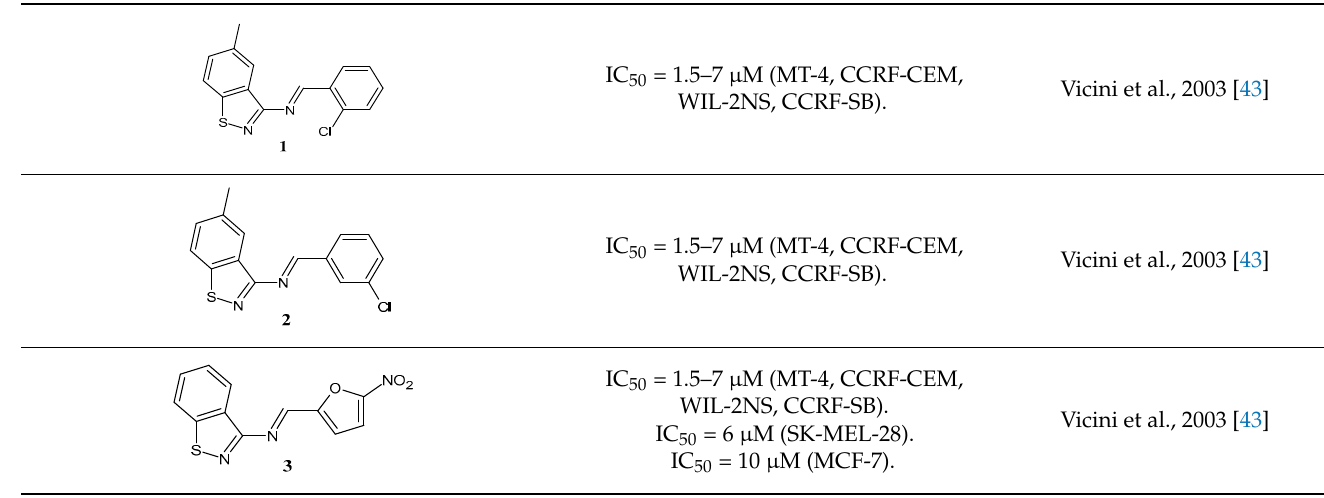
Table 1. Mono-Schiff bases.